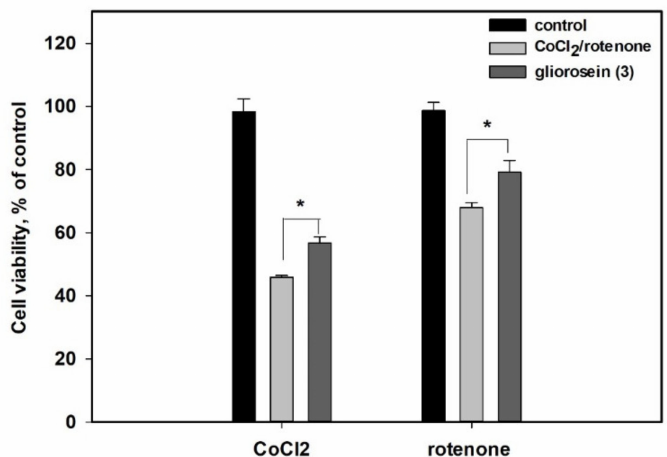
Figure 6. The cytoprotective activity of gliorosein ( 3 ) at 10 µ M against CoCl 2 -mimic hypoxia and rotenone toxicity in H9c2 cells. The data are presented as a mean ± standard error of mean (SEM). * The differences are significant with p ≤